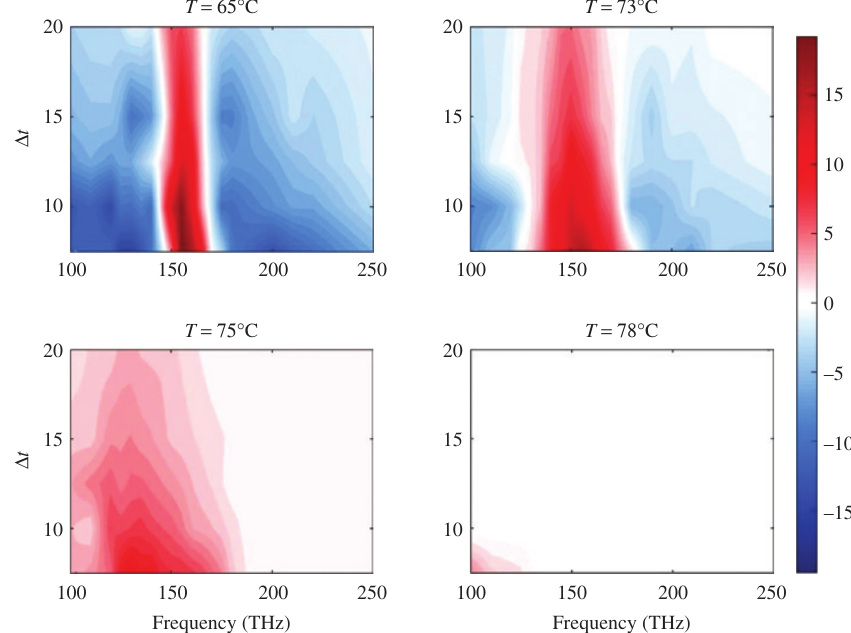
Figure 3: Half-power pulse span compression (red) and expansion (blue) percentage for various pulses with variable carrier frequencies and spans at different